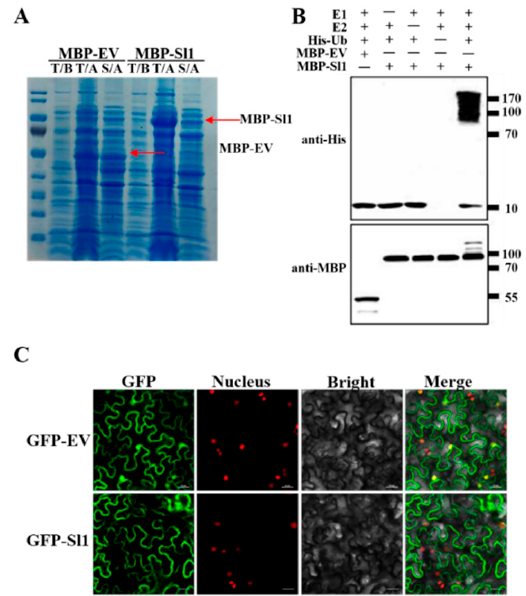
Figure 2. E3 ligase activity and subcellular localization of Sl1. ( A ) In vitro expression of MBP-Sl1 and MBP-EV. T: total protein; S: soluble protein; B: before expression; A: after expression. ( B ) In vitro E3 ligase activity of Sl1 protein. The reaction system included E1, E2, MBP-Sl1, and ubiquitin-His, the replacement of MBP-Sl1 with MBP-EV and the absence of E1, E2, and His-Ub as control. The Western blot was detected with anti-MBP and anti-His. ( C ) Subcellular localization of GFP-Sl1 and GFP-EV. The GFP-Sl1 was transiently expressed in Nicotiana benthamiana (tobacco with nucleus- located mCherry). Images were pictured by confocal microscope after 48 h infiltration. Bar = 25 µ